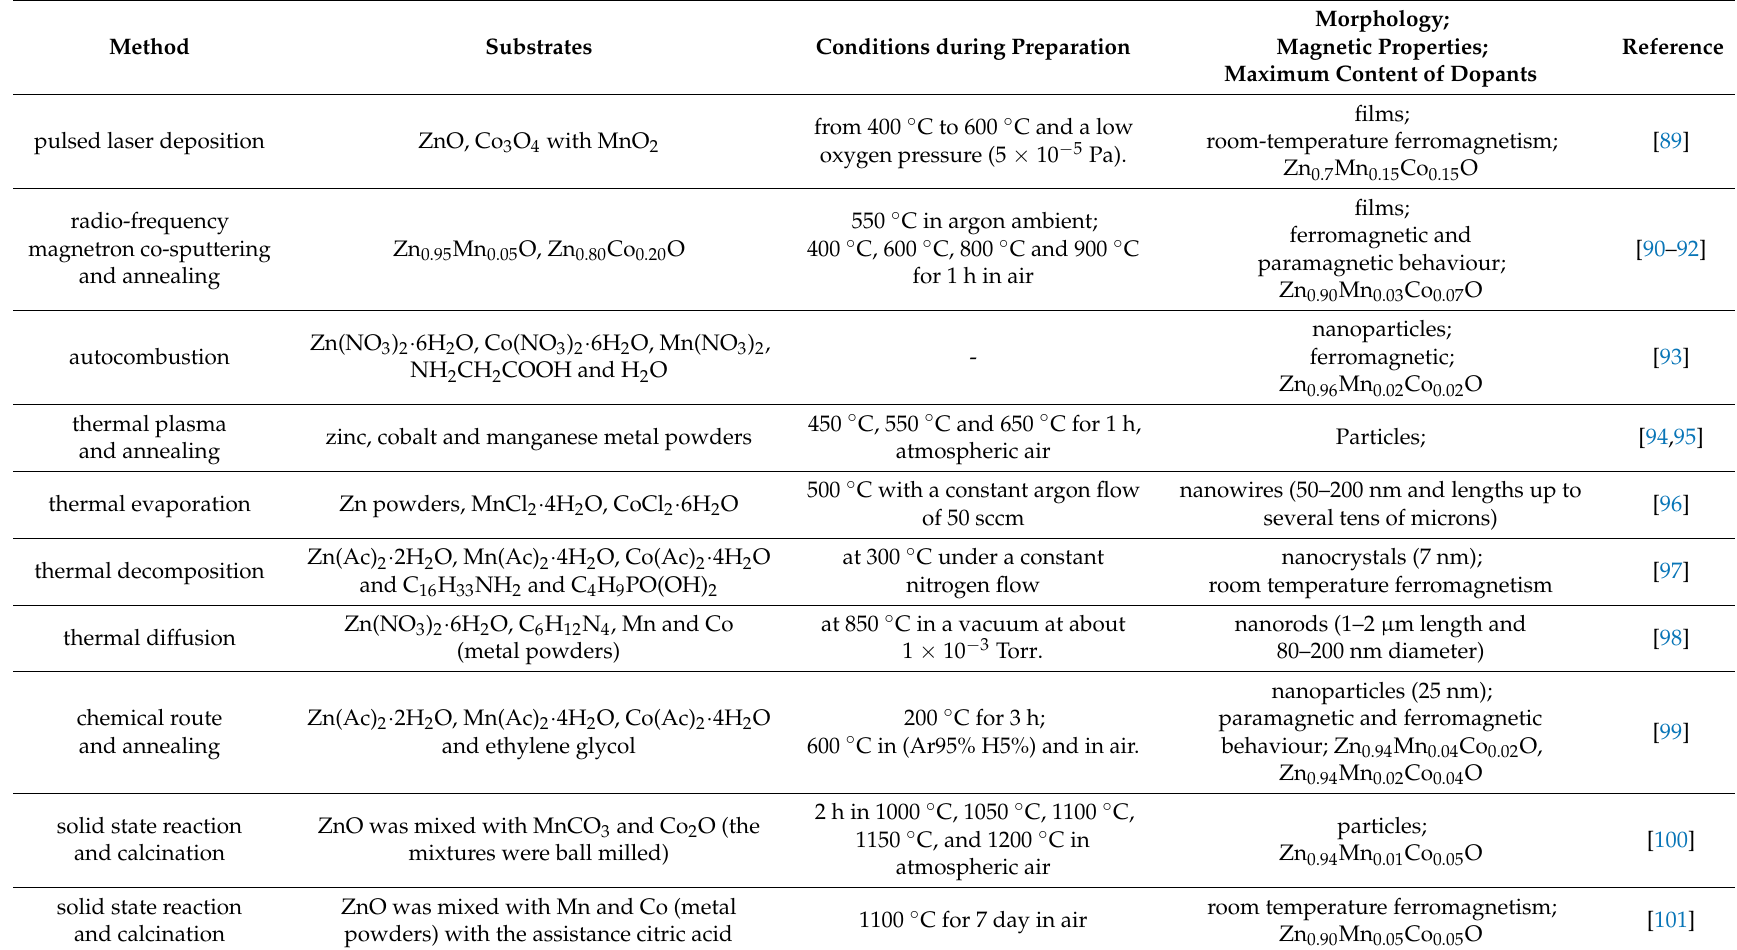
Table 2. Summary of methods of obtaining Mn 2+ -and Co 2+ -codoped